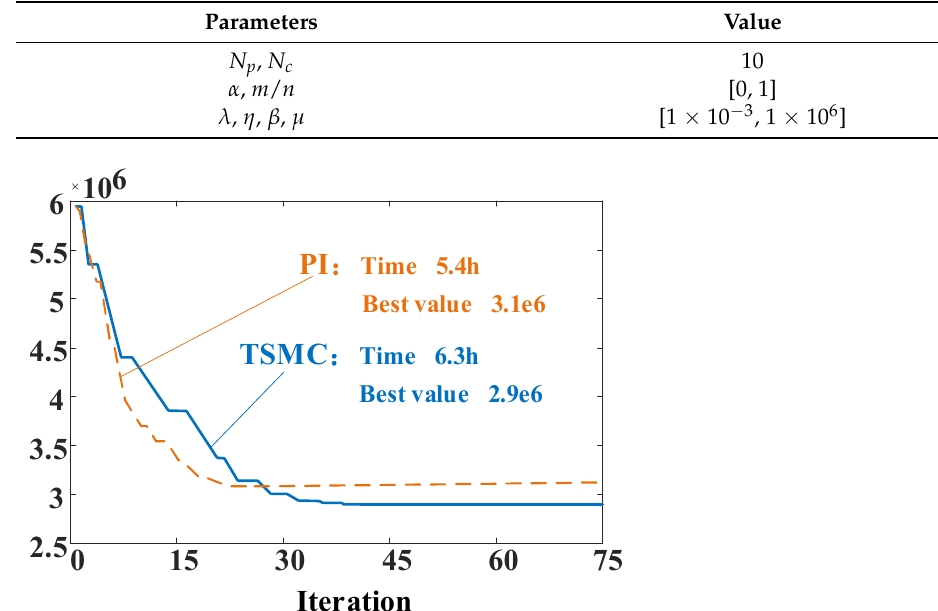
Table 1. Setting and parameters range of optimization.